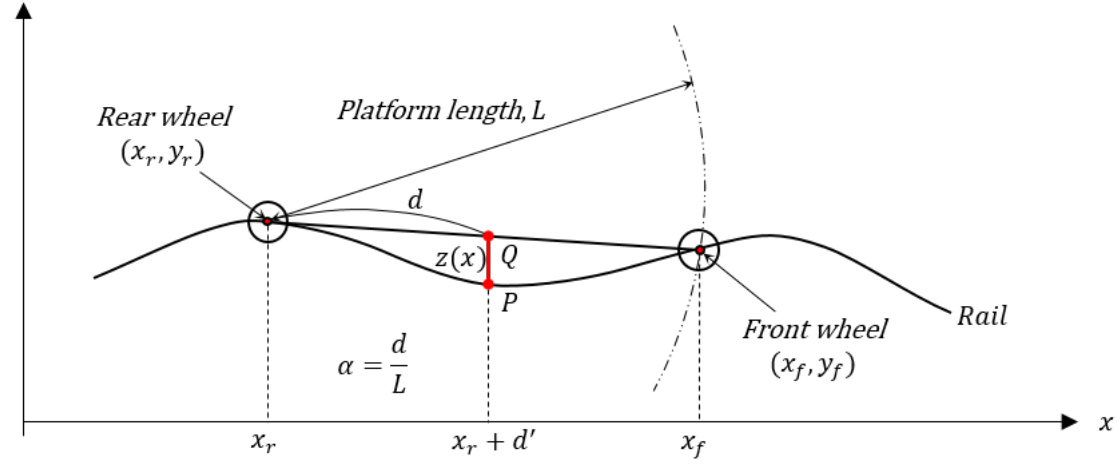
Figure 4. Single-sensor-based chord offset synchronizing model ( d is the distance between x r and the sensor, and d (cid:48) is the projection of d